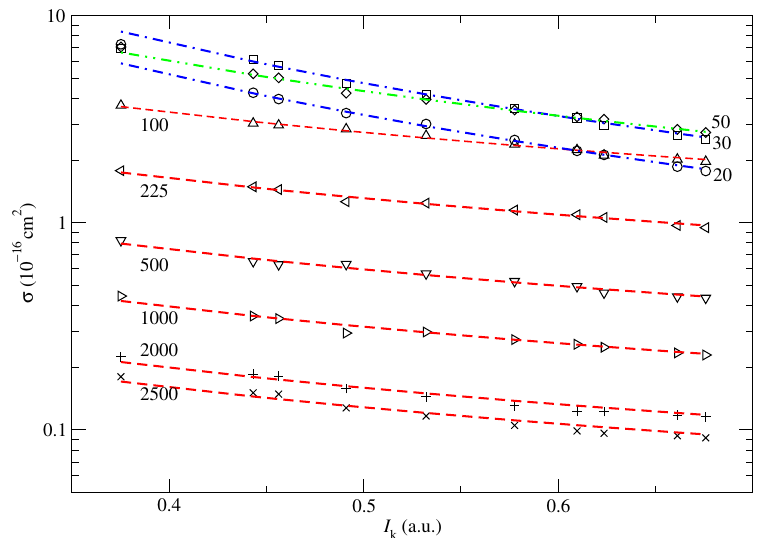
Figure 6. Electron production cross sections from individual MO of uracil after collision with protons, given by their ionization energy I k . The different symbols correspond to different collision energies specified in the figure with numbers in keV. The lines are the fitted Equation (7).